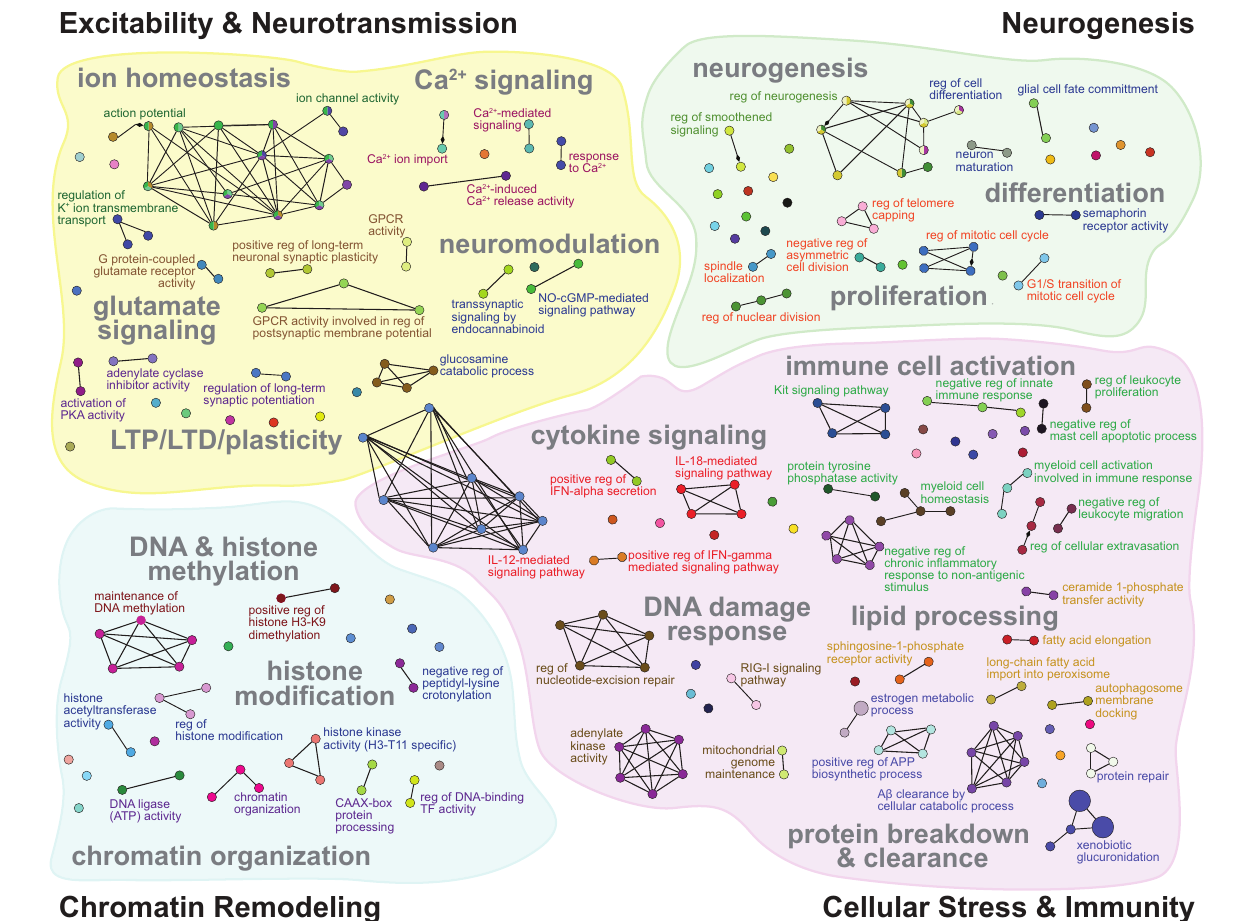
FIGURE 3 | GO networks of representative terms related to excitability and neurotransmission, neurogenesis, chromatin remodeling, and cellular stress and immunity that are enriched by (cid:49) FosB targets in both APP and Pilo mice. GO networks for the subset of 442 genes bound by (cid:49) FosB in both APP and Pilo mice, grouped into Excitability and Neurotransmission (top left), Neurogenesis (top right), Chromatin Remodeling (bottom left), and Cellular Stress and Immunity (bottom right). GO terms (nodes) enriched with target genes are represented as circles, whose sizes increase with increasing statistical significance of the enrichment. Lines connect nodes with shared genes. Colored font indicates the leading term of the associated cluster. See Supplementary Table S1 for full listing of the GO Terms represented by each node pictured.